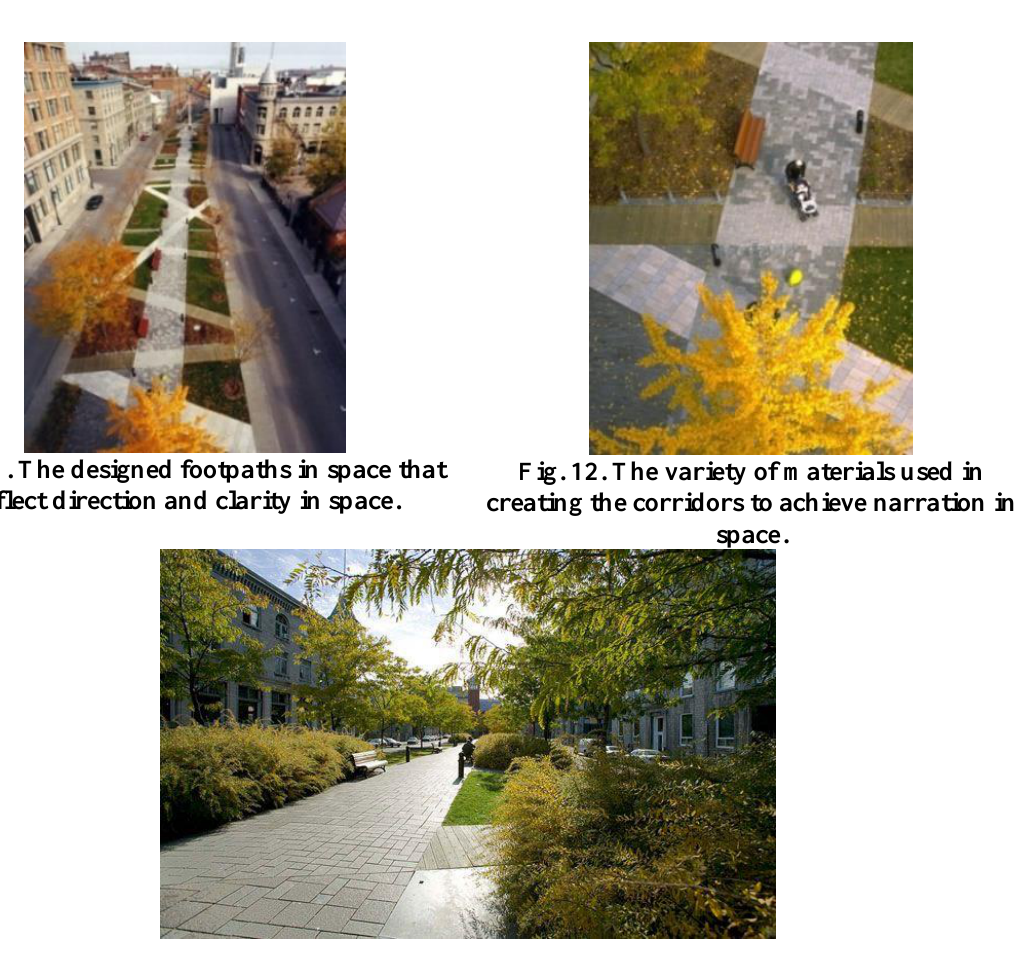
Fig. 13. Increasing the diversity of green spaces to reduce heat gain by providing large green spaces and increasing greening by planting leafy trees Source: